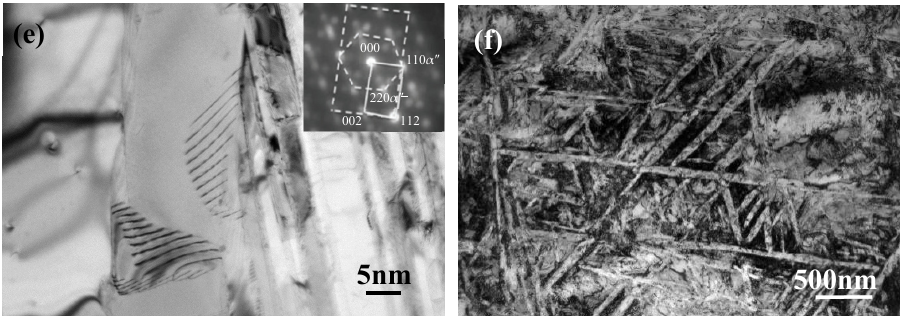
Figure 5. TEM images of the alloys with different aging treatment after fatigue tests under 1.4% total strain range. ( a ) 4 h, ( b – e ) 12 h and ( f ) 24 h.